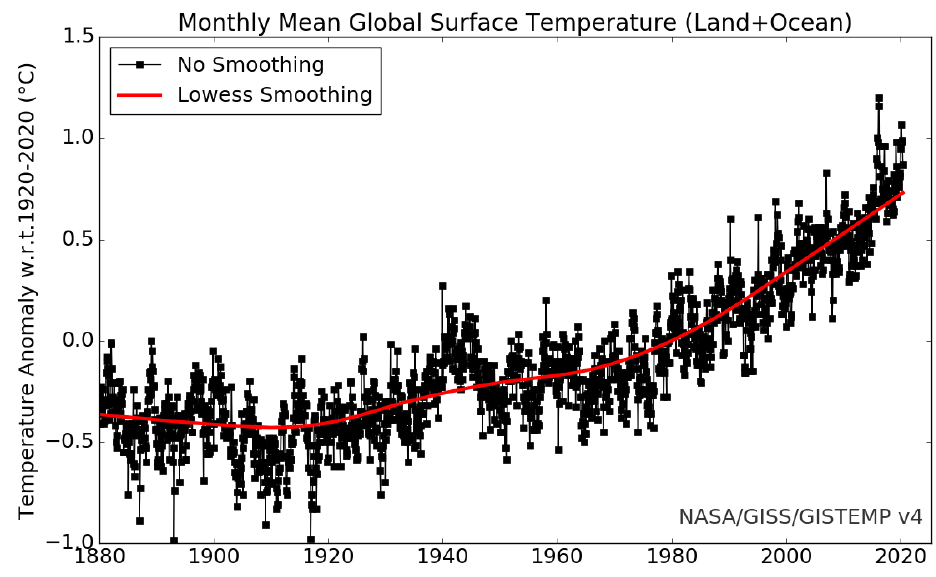
Figure 1. Monthly global mean surface temperature over 140 years